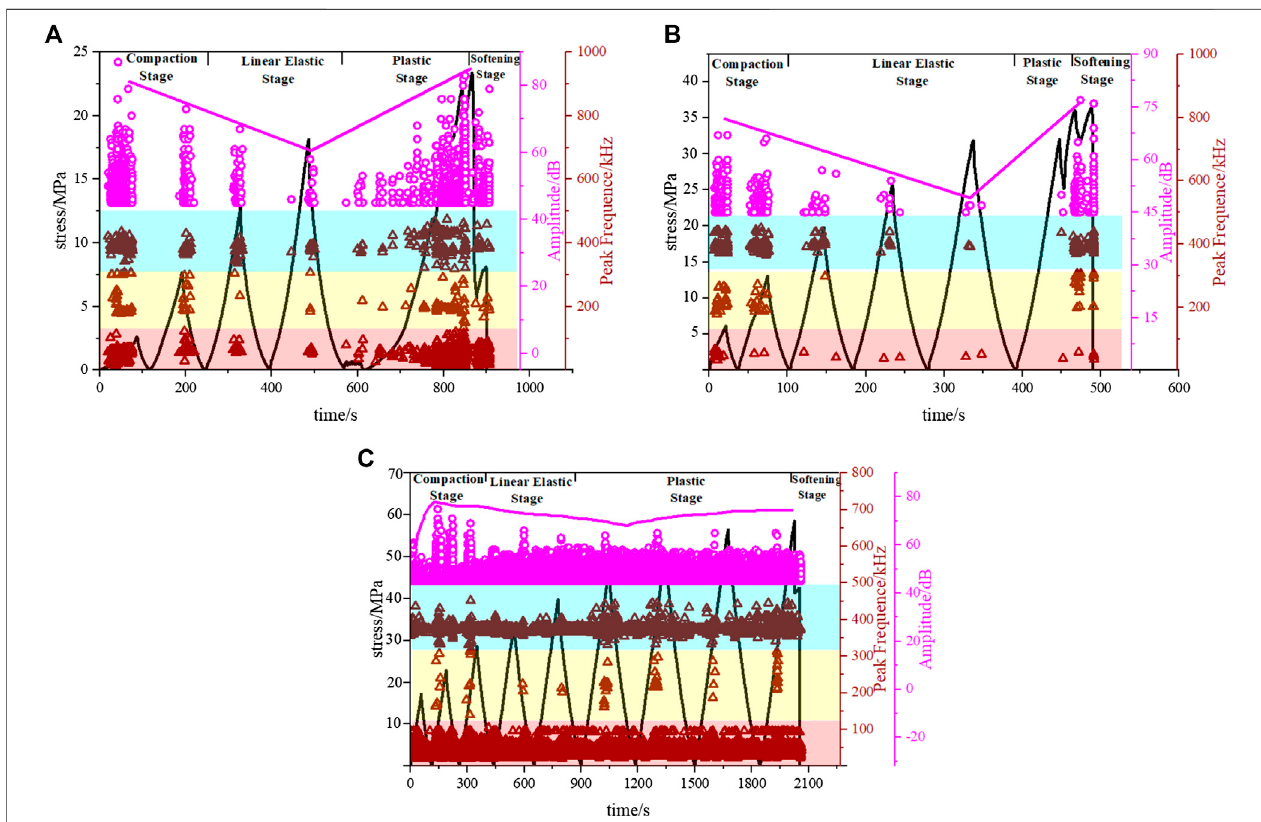
FIGURE 7 | Variation process of the amplitude and peak frequency signals under different initial stresses (A) σ 0 (cid:2) 2.5 MPa, (B) σ 0 (cid:2) 7.5 MPa; (C) σ 0 (cid:2) 12.5 MPa.